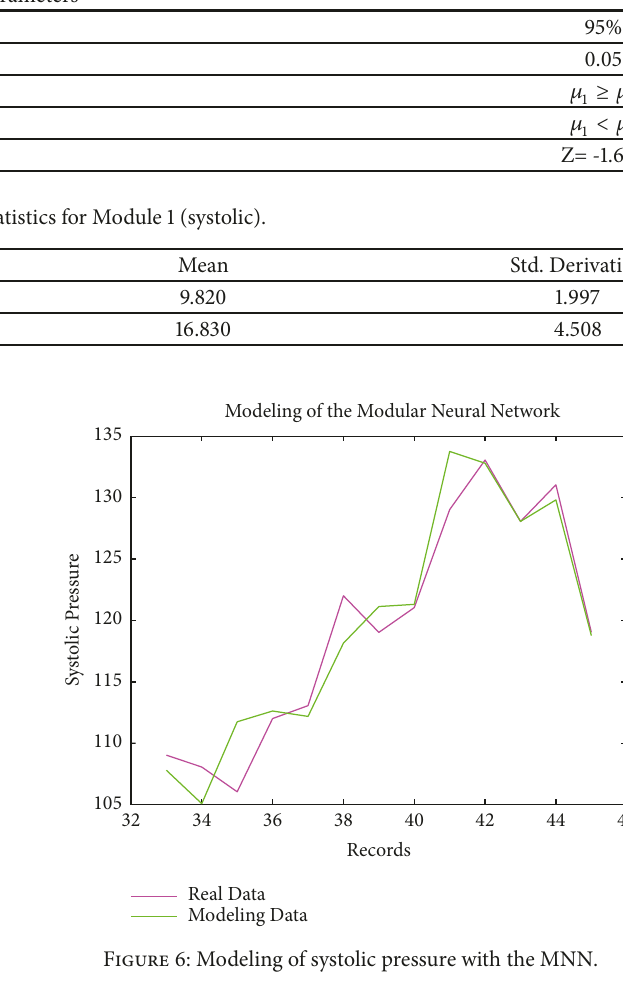
Figure 5: Modeling of diastolic pressure with the MNN.